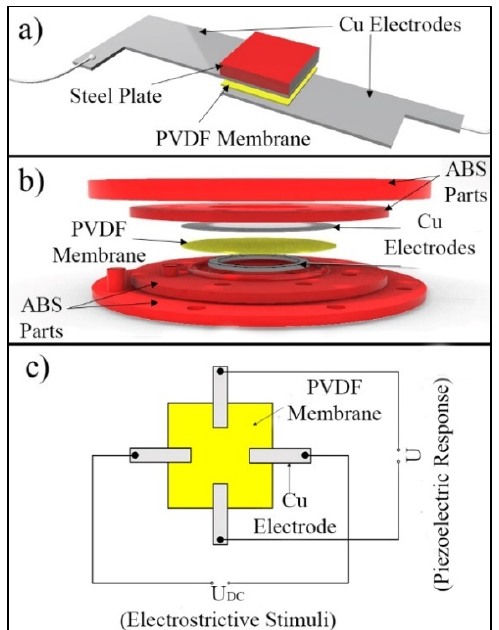
Scheme 2. Three types of experimental setups with incorporated PVDF electrospun non-woven membrane to detect and measure piezoelectric and electrostriction responses ( a ) to mechanical load- ing by pressure pulse, ( b ) detection of the sound of clapping hands, ( c ) conversion of electrostriction to piezoelectric